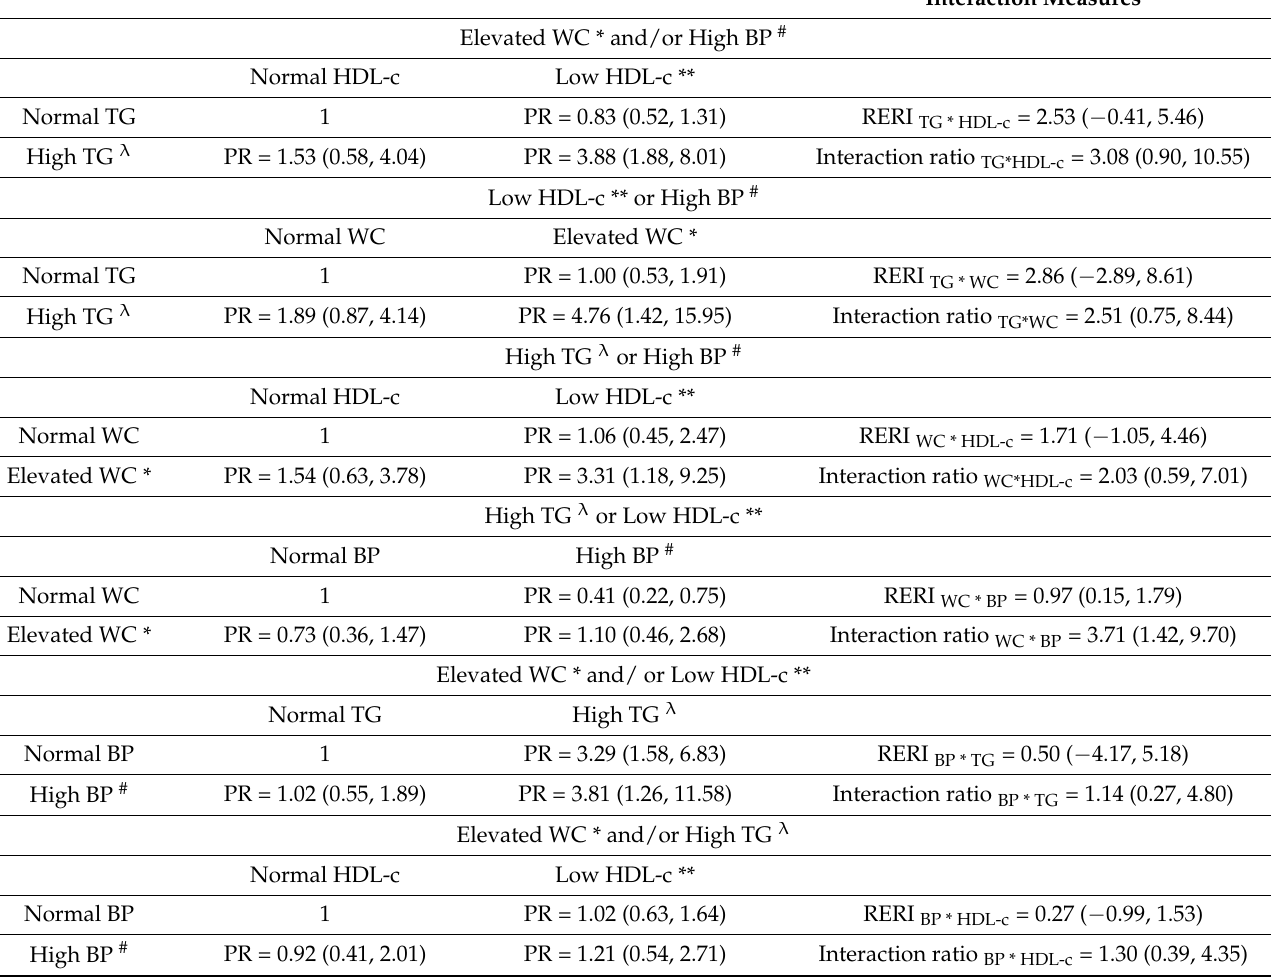
Table 2. Adjusted ‡ Prevalence Ratios (PR) to assess the interaction between pair-wise clusters of metabolic syndrome components with type 2 diabetes mellitus Γ as the outcome, in the stratum formed by at least a third metabolic syndrome variable δ in 37,815 adolescents in the Study of Cardiovascular Risk Factors (ERICA,